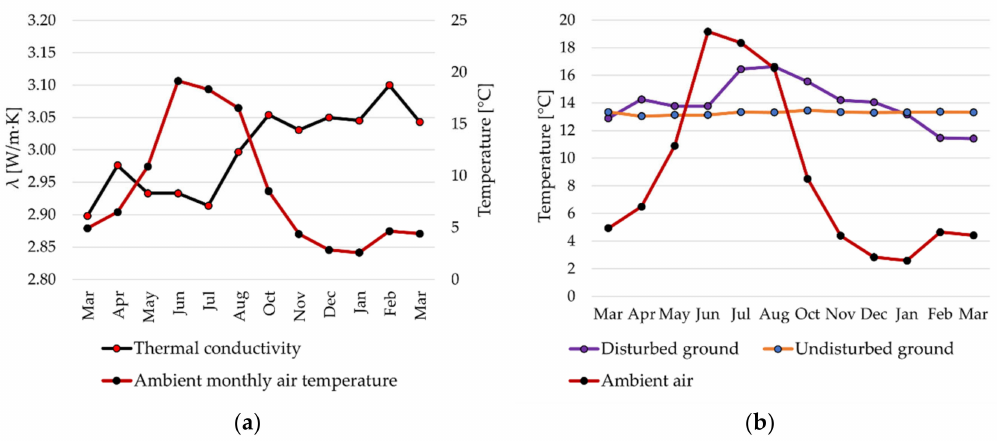
Figure 6. Correlation of mean ambient air temperature with ( a ) the thermal conductivity λ calculated via ILS and ( b ) the mean disturbed ground temperature obtained at a depth of 20 m b. g. l., as well as the mean undisturbed ground temperature obtained from 20 to 120 m b. g. l.; ambient air temperature data from DWD (German Weather Service) weather station “282 Bamberg” at 2 m above ground; for data source, see